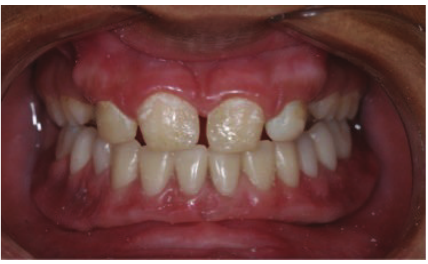
Figure 5: After prosthesis